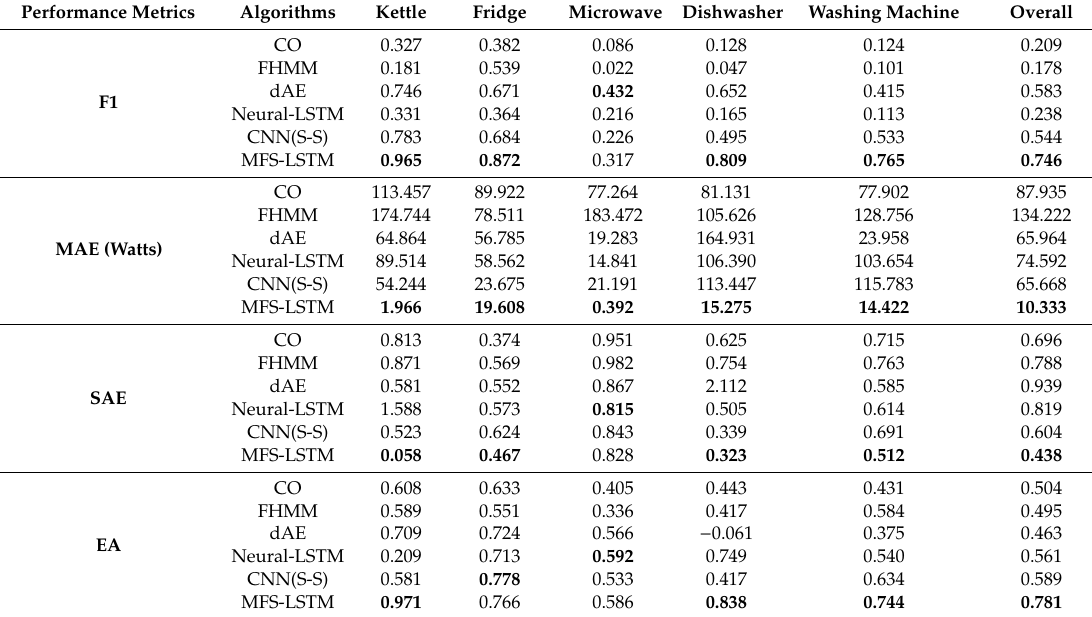
Table 8. Performance evaluation of disaggregation algorithms in the unseen